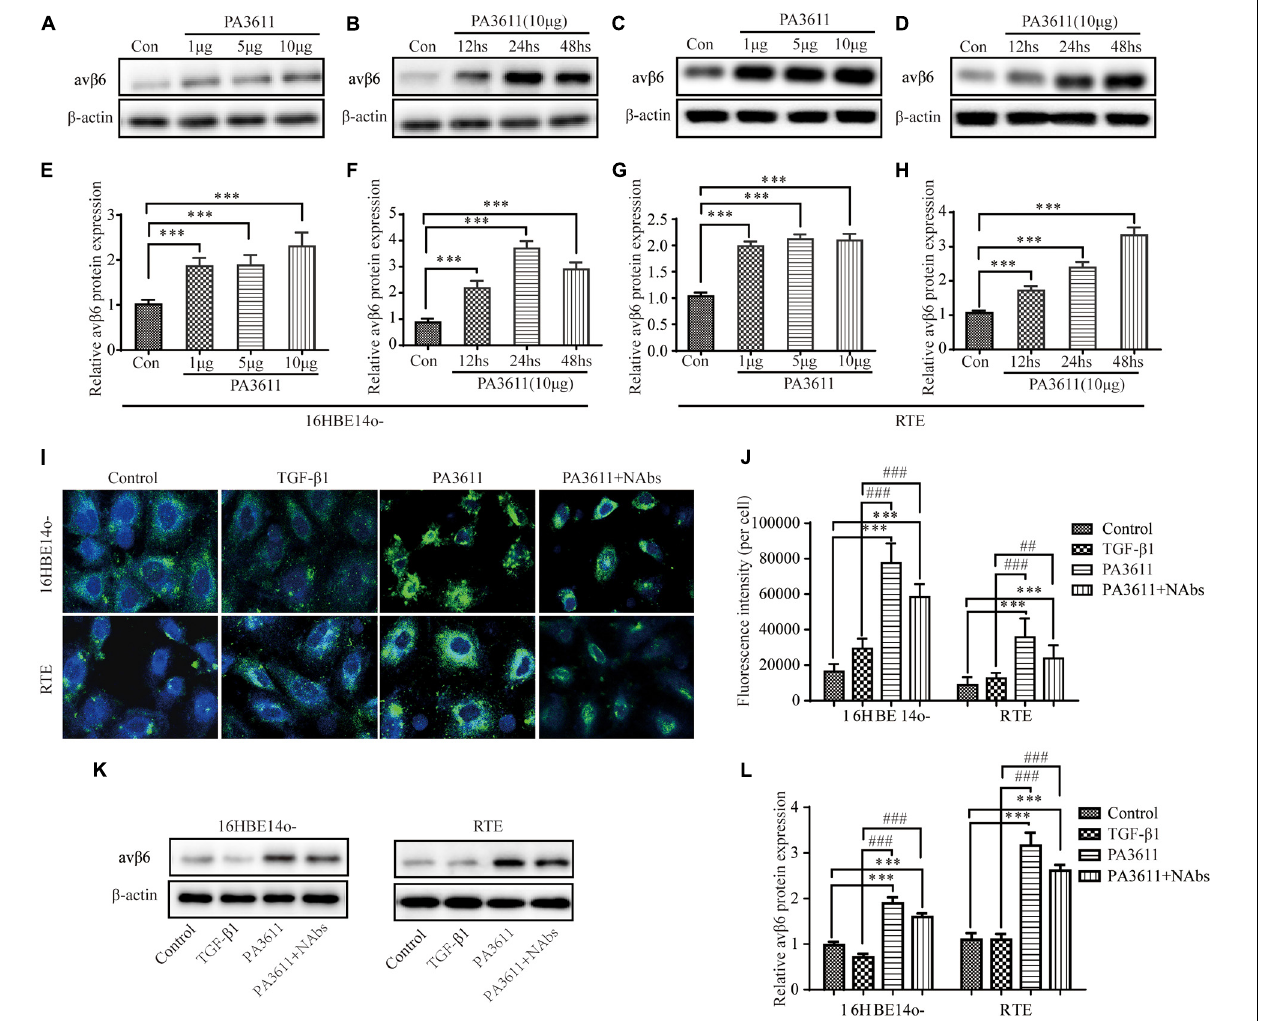
FIGURE 4 | PA3611 but not TGF- β 1 stimulated av β 6 protein expression. 16HBE14o- and RTE cells were treated with different concentrations of PA3611 (1, 5, and 10 µ g/mL) for different durations (12, 24, and 48 h), and α v β 6 expression was detected by Western blotting (A–H) . 16HBE14o- and RTE cells were treated